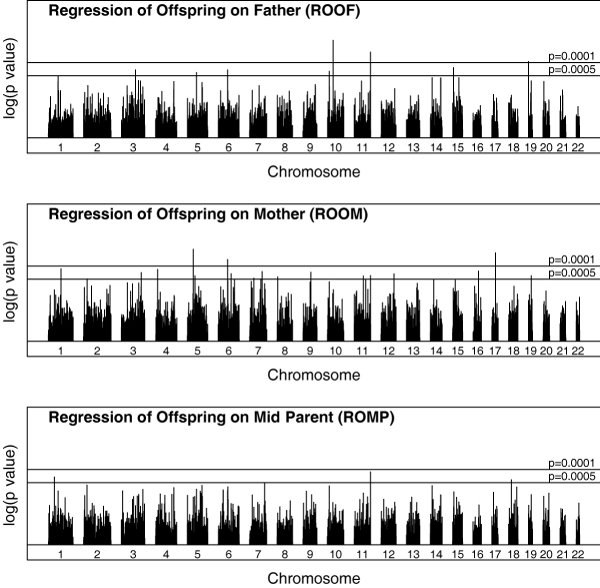
Results of tests of association with ECB21 for all SNPs in the non-Hispanic White subjects.